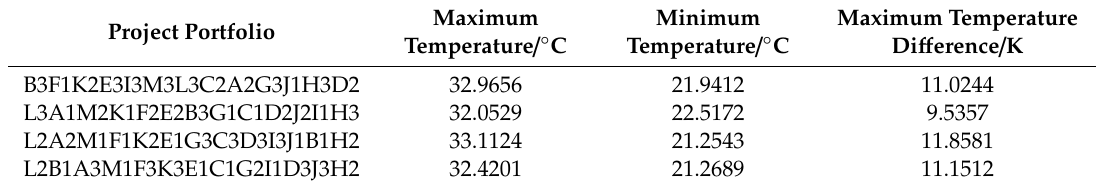
Table 4. Thermal simulation results of optimization scheme.